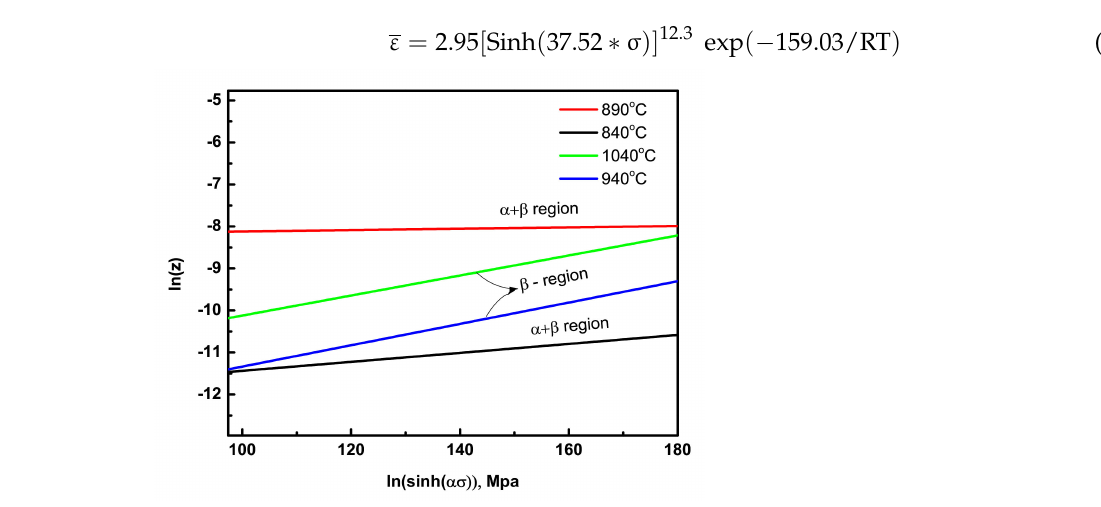
Figure 5. Plot of the relationship between ln(sinh( ασ )) and lnZ at a strain rate of 0.01 s − 1 for determining the material constant,